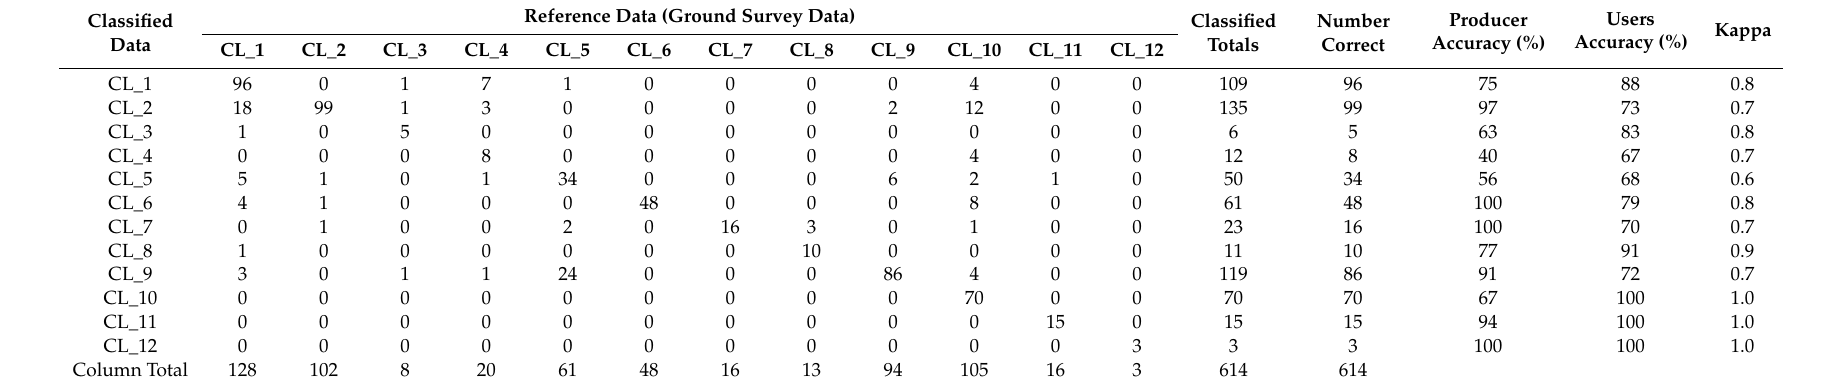
Table 7. Accuracy assessment using ground survey data using error matrix method for the year